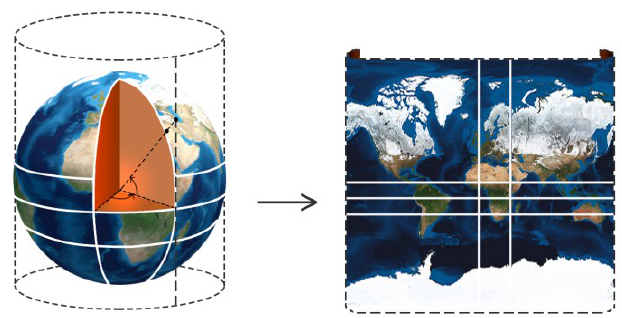
Fig. 3: Mercator Projection